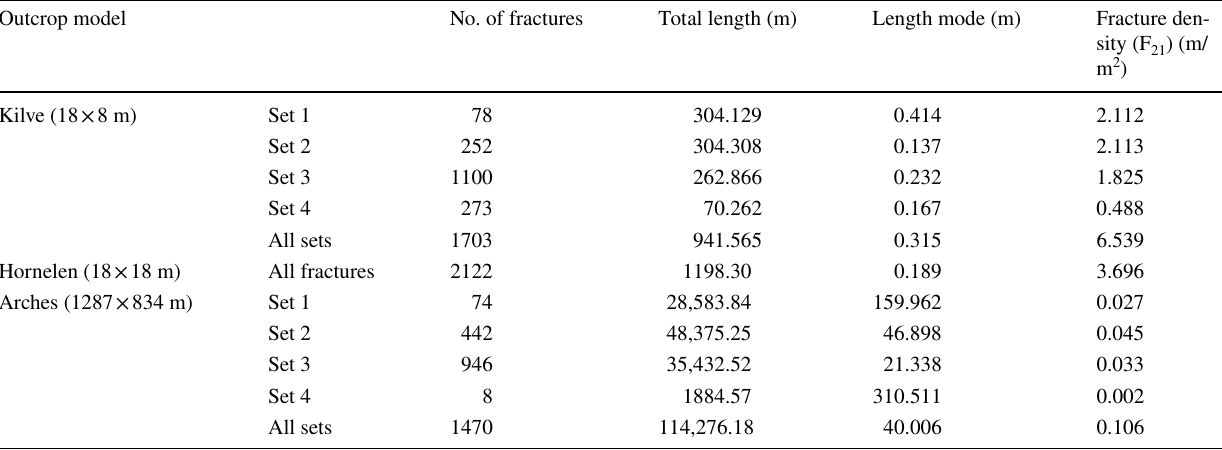
Table 1 Fracture length and density calculated using the area method of Wu and Pollard (2002) Outcrop